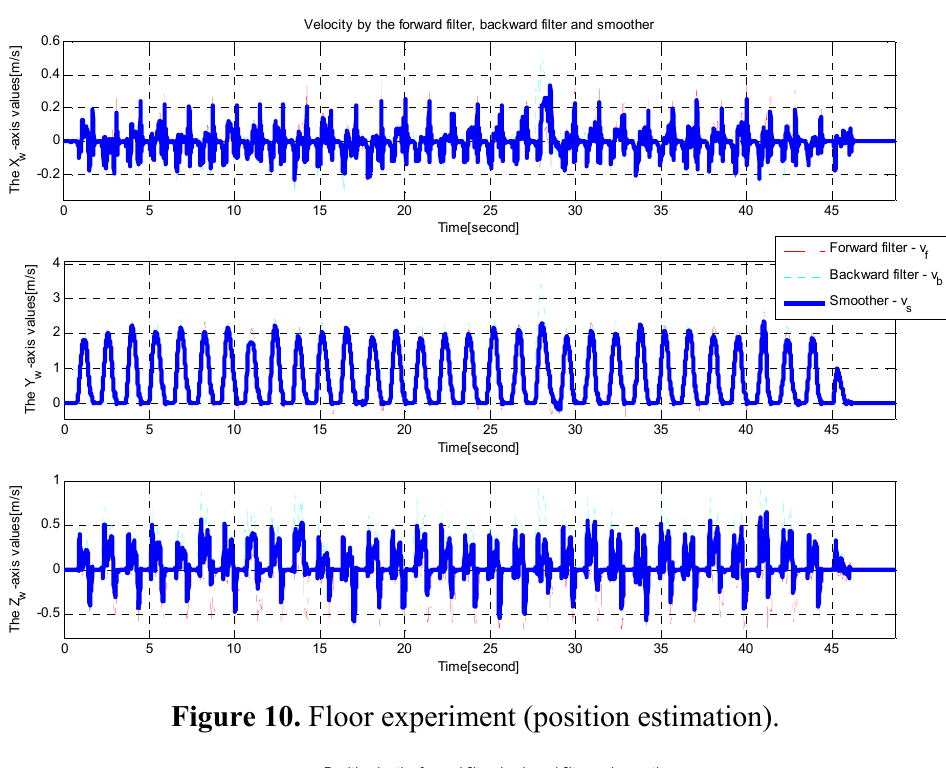
Figure 9. Floor experiment (velocity estimation).